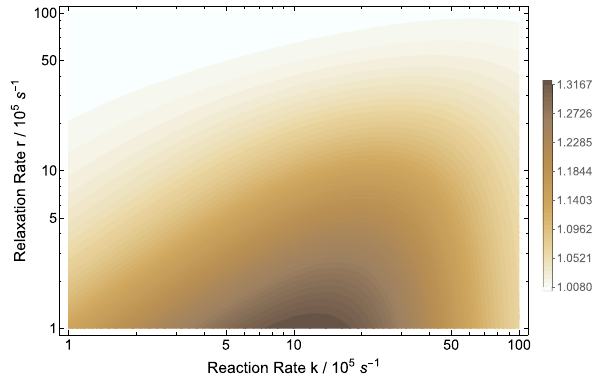
Figure 3. The RPM model prediction of the microtubule density ratio in geomagnetic field compared to hypomagnetic field based on the RP complex of [ TrpH . + . . . O2 . − ]. The geomagnetic field and hypomagnetic field are 0.05 mT and 10 nT, respectively. The magnetic field modulates rate k p for a A = 1.6046 mT. The